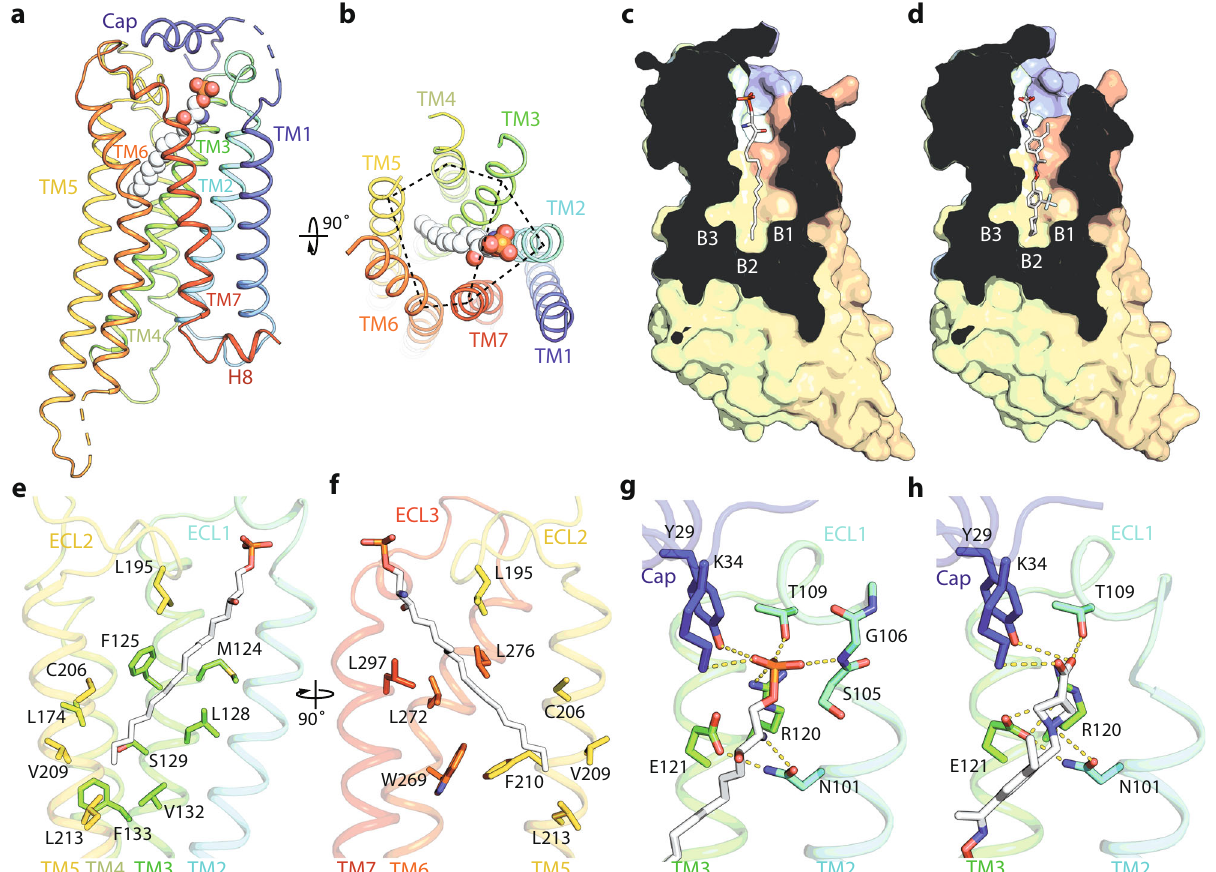
Fig. 2 Interactions between S1P or Siponimod and S1P 1 . a , b Cartoon representation of S1P 1 with the bound S1P in spheres, and rotated 90° to show the two binding modules of transmembrane (TM) helices indicated by dashed lines. c , d Slice through views of the ligand-binding pockets of S1P 1 with the side binding pockets B1, B2 and B3 indicated. e , h Residues involved in interacting with the hydrocarbon chain ( e – h ) or the polar head group ( g , h ) of S1P or Siponimod are shown in